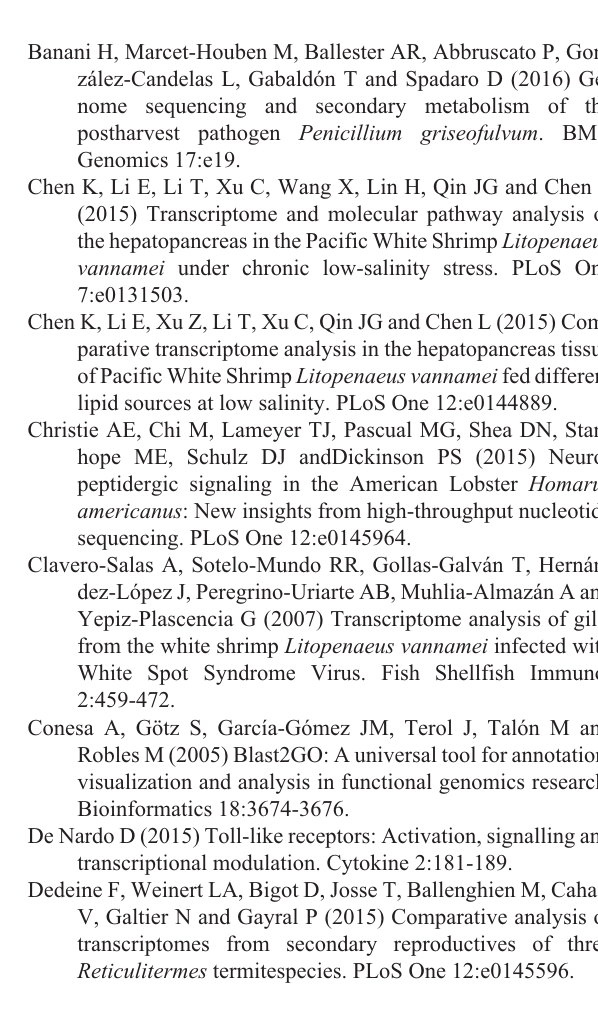
Figure 7 - Significant differentially expressed genes (DEGs) identified by KEGG involved in the Toll-like receptors (TLRs) signaling pathway. Red boxes indicate significantly increased expression, green boxes indicate significantly decreased expression, and black boxes indicate unchanged expres-